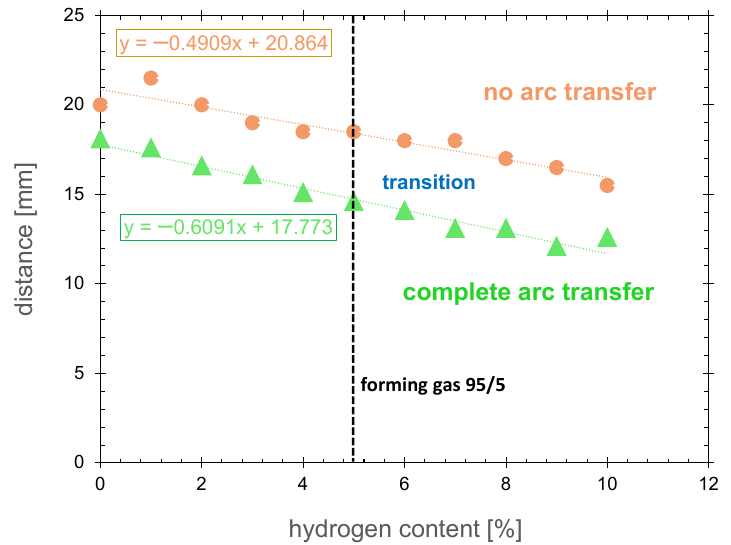
Figure 8. The distance between the nozzle tip and the grounded surface at which the transition between the non-transferred and transferred arc operation modes occurs, displayed as a function of hydrogen percentage in the nitrogen/hydrogen gas mixture. These results were determined for an HV pulse frequency of 65 kHz and a total gas flow of 60